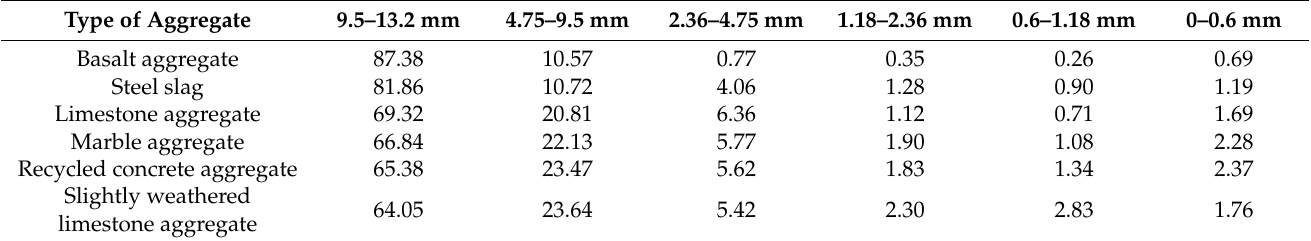
Table 7. Aggregate particle distribution after Marshal hammer